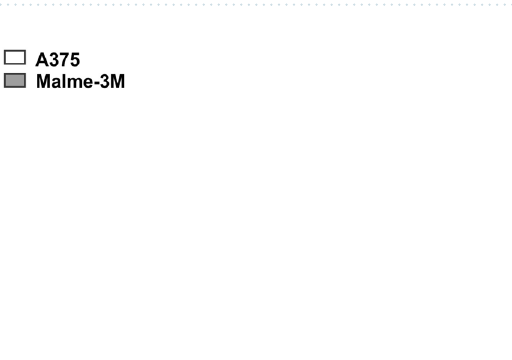
Figure 3. Gene expression after 24 h hypoxia or PHD inhibitor treatment in Malme-3M. Average fold change expression of three hypoxia control genes ( CAIX , GLUT1 , and PHD2 ) and CYGB , compared to the normoxic control (set as 1), after 24 h of roxadustat (100 µM), hypoxia (0.2% O 2 ), and combined hypoxia and roxadustat (100 µM). qPCR values were normalized to B2M and YWHAZ (mean ± S.E.M; n = 3). Individual values of replicates are depicted as black dots. One-way ANOVA (* p ≤ 0.05; ** p ≤ 0.01; **** p ≤ 0.0001).